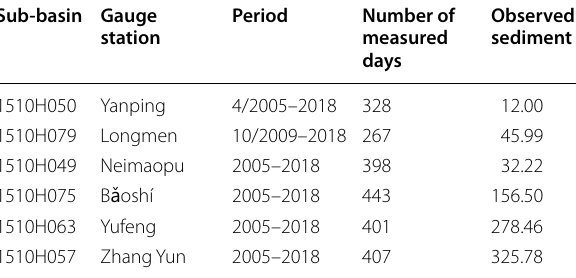
Table 6 Annual suspended sediment discharge (10 6 t year − 1 ) at gauge stations Sub-basin Gauge station